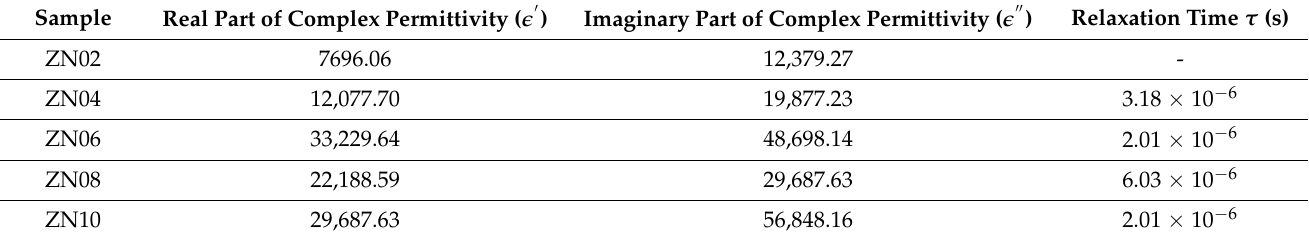
Table 3. Variation of real and imaginary of complex permittivity at 10 Hz and relaxation time for polymer electrolyte sample as a function of ZnO